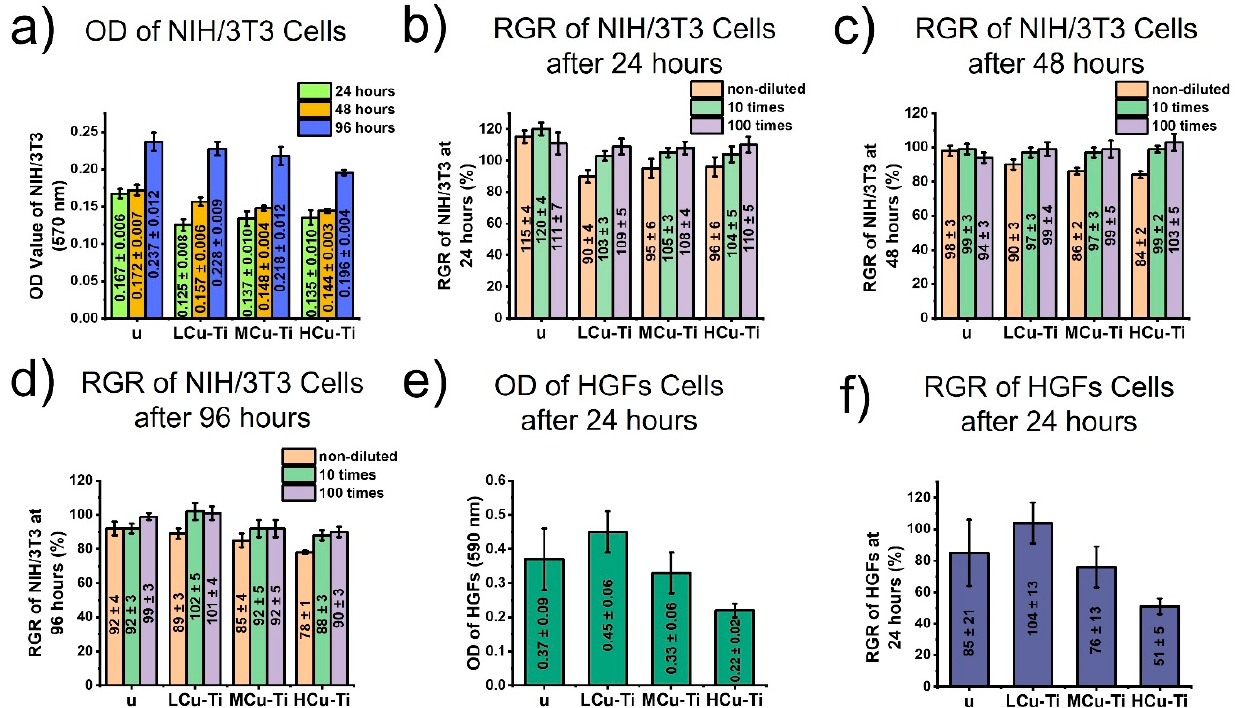
Figure 5. Cytotoxicity of unmodi fi ed (u) and surface-modi fi ed PLGA sca ff old samples (LCu-Ti, MCu-Ti, HCu-Ti): ( a ) optical density (OD) of NIH/3T3 cells incubated with non-diluted PLGA sam- ple extracted at di ff erent times (24, 48 and 96 h); ( b – d ) relative growth factors (RGR) of NIH/3T3 cells incubated with non-diluted, 10 times diluted and 100 times diluted PLGA sample extracted after 24 h ( b ), 48 h ( c ) and 96 h ( d ); ( e ) optical density (OD) of human gingival fi broblasts incubated with PLGA samples for 24 h; ( f ) relative growth rate (RGR) of human gingival fi broblasts incubated with PLGA samples for 24